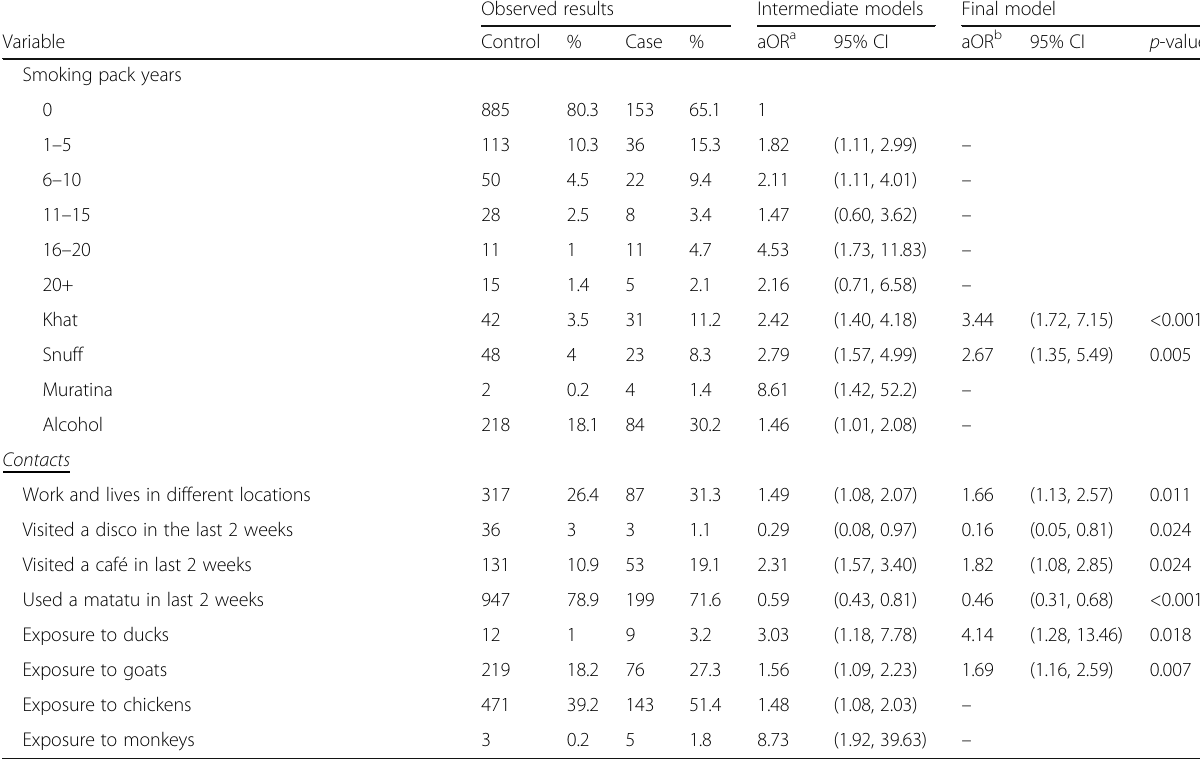
Table 3 Risk factors for pneumonia in intermediate and final regression models